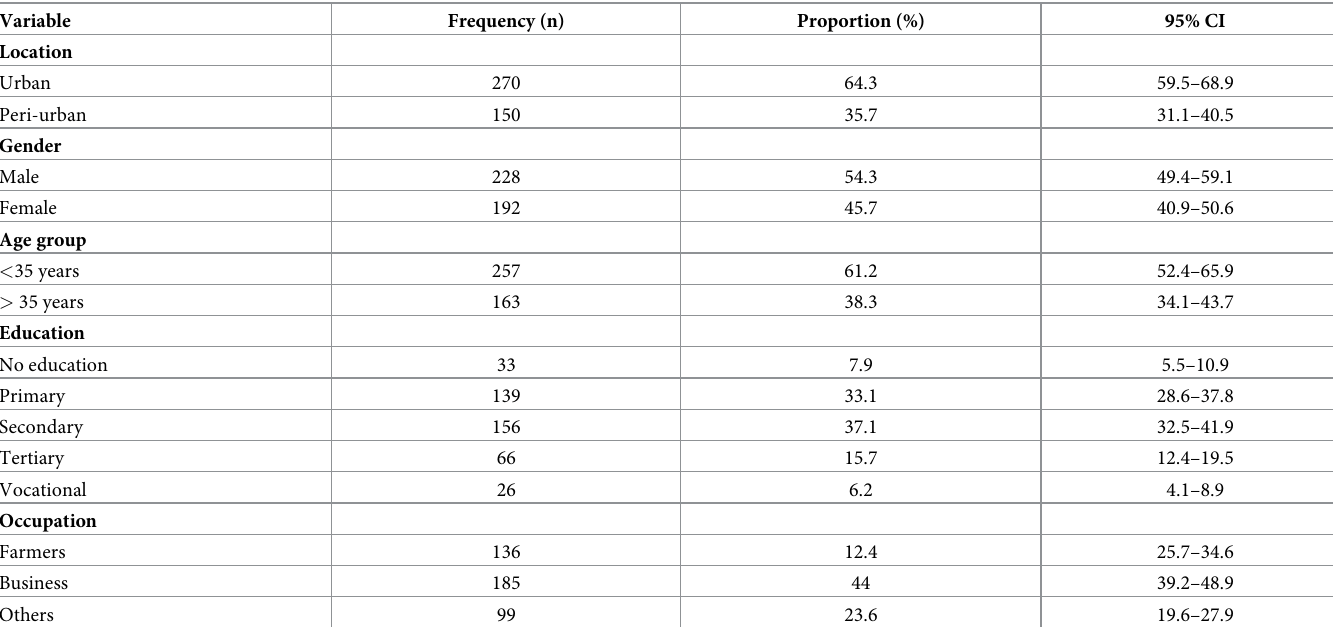
Table 1. Demographic information of respondents.